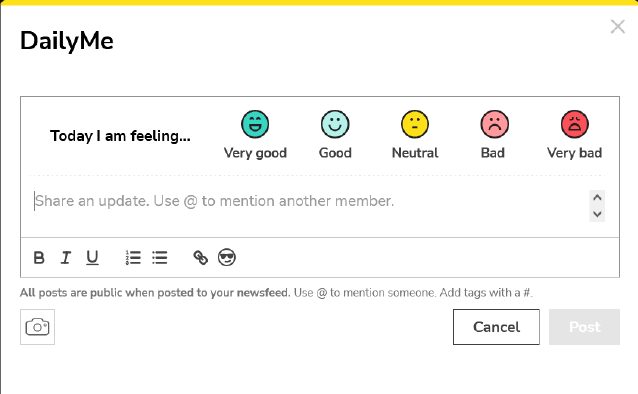
Figure 13. DailyMe